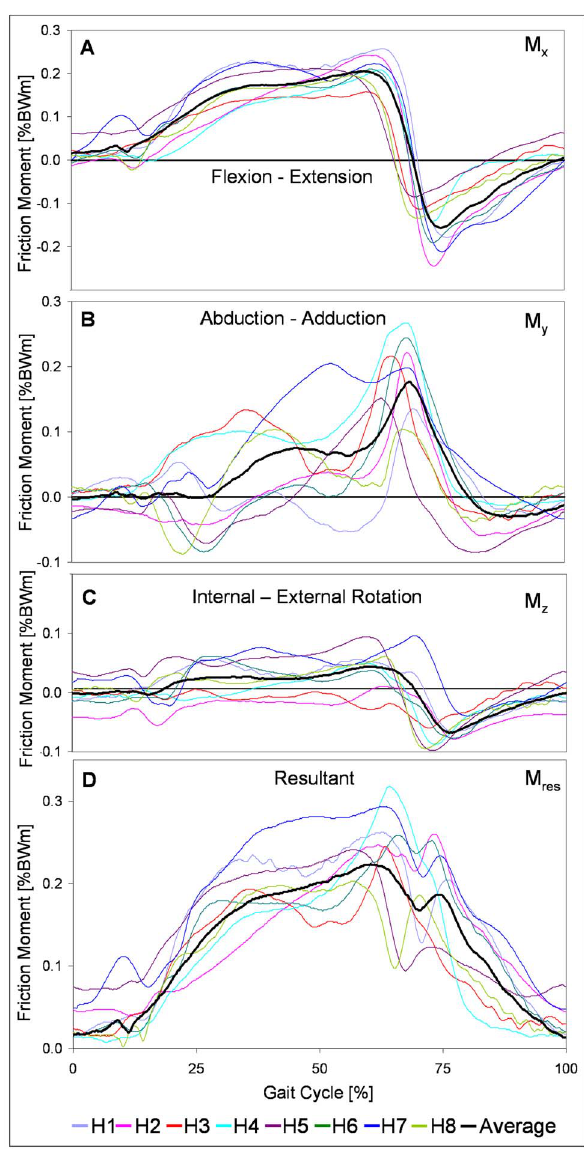
Figure 4. Components of friction moment. Components M x , M y , M z around x, y, z axes (see Figure 1). Individually averaged patterns of subjects H1 to H8 (color), and average patterns of all subjects